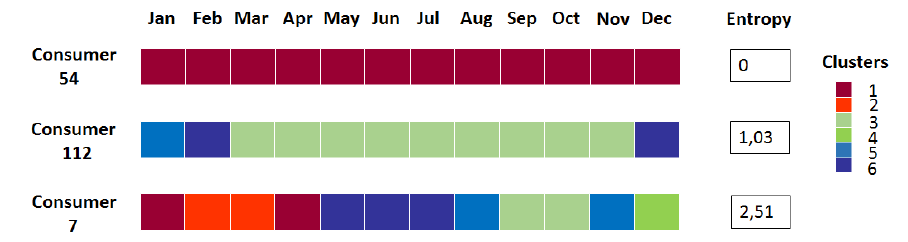
Figure 12. Evolution of the monthly electricity consumption behaviors of three consumers over the